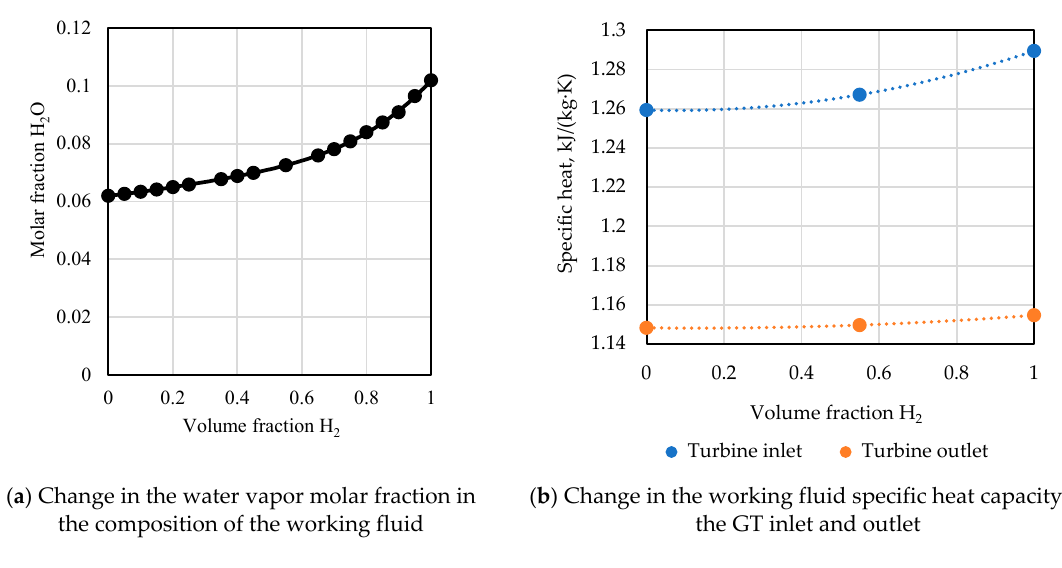
Figure 10. Influence of the volume fraction of hydrogen on the thermodynamic properties of the working fluid.